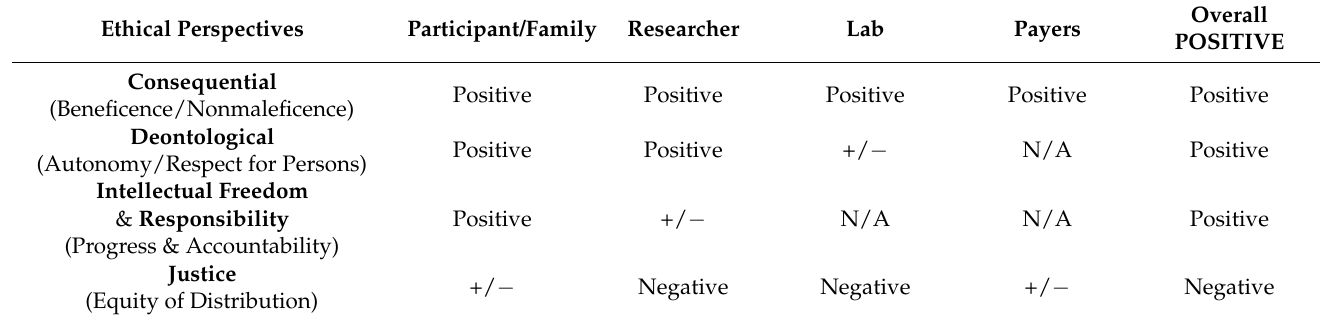
Table 3. Alternative Policy.